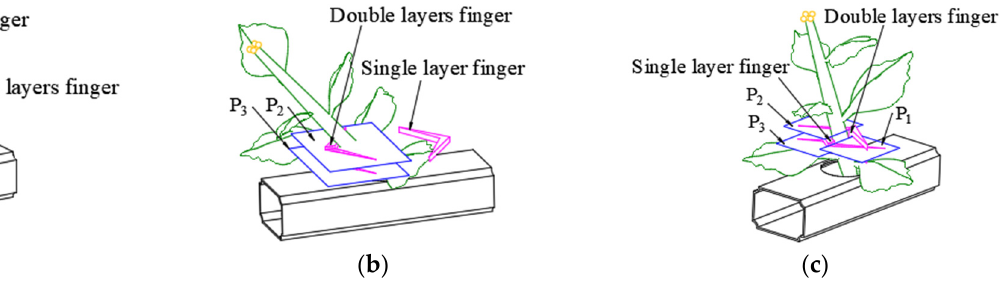
Figure 5. Three-layer contact surfaces of two V-shaped cross fingers: ( a ) illustrates the middle sing- layer finger contact surface, ( b ) illustrates the double-layer finger contact surfaces, and ( c ) is the cross-clamping illustration of the two fingers.